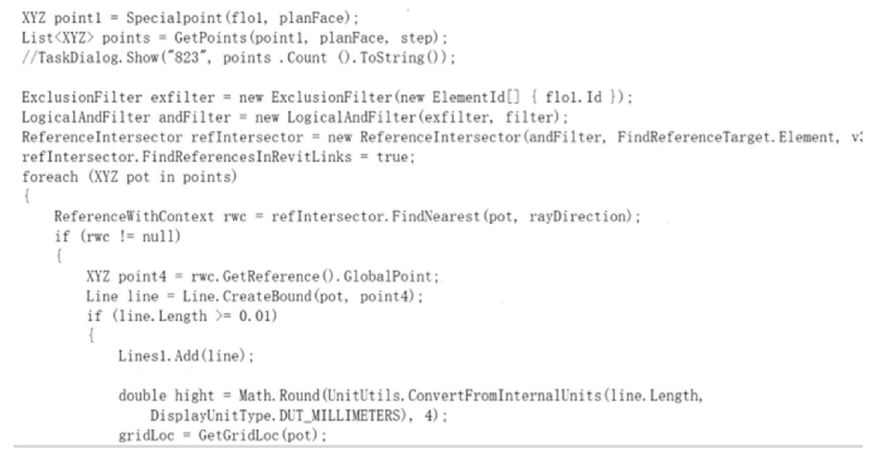
Fig. 5 Key code of ray